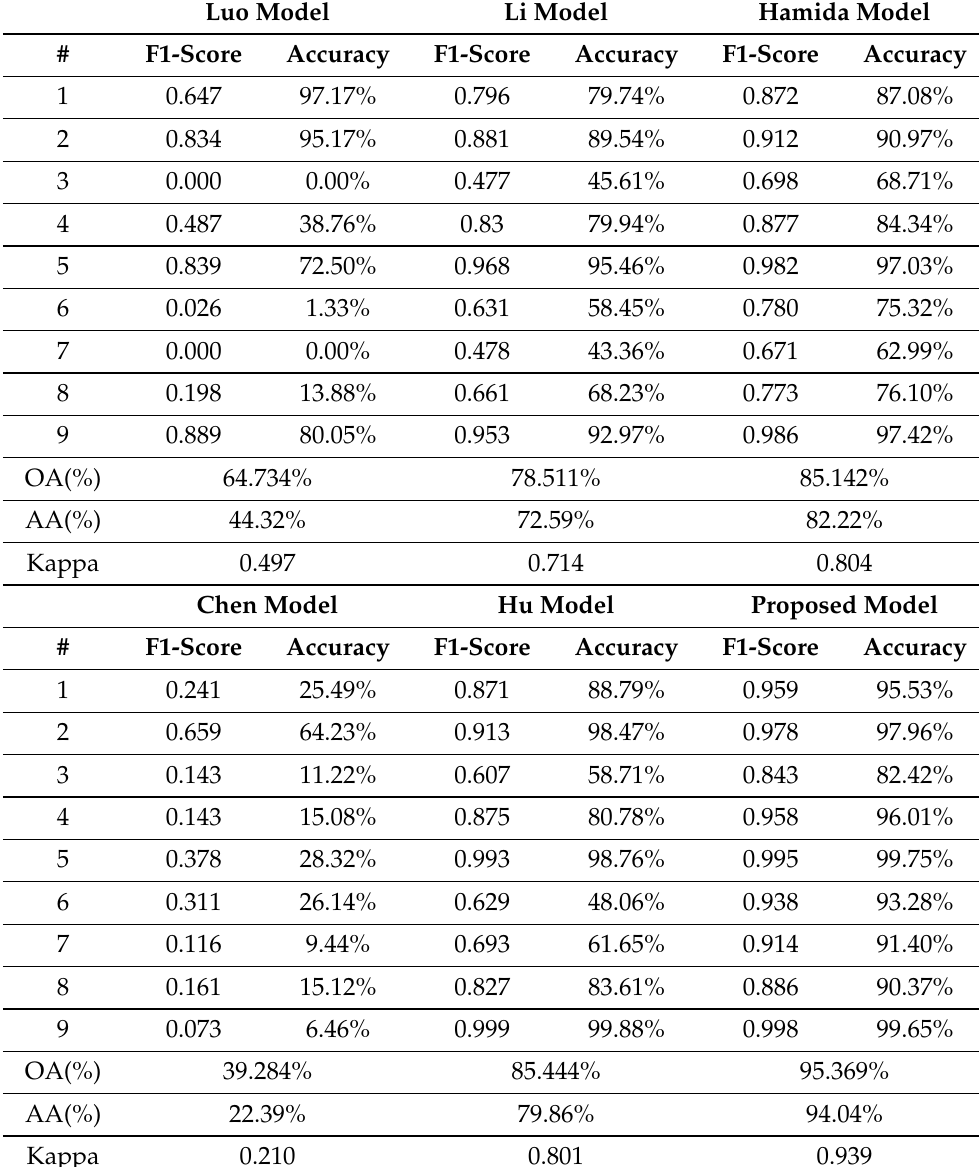
Table 12. Classification results of the Pavia University dataset to which random spatial information is